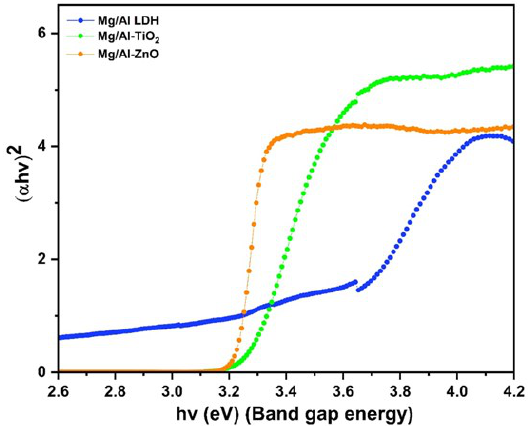
Fig. 2. Band Gap Energy of LDH Materials